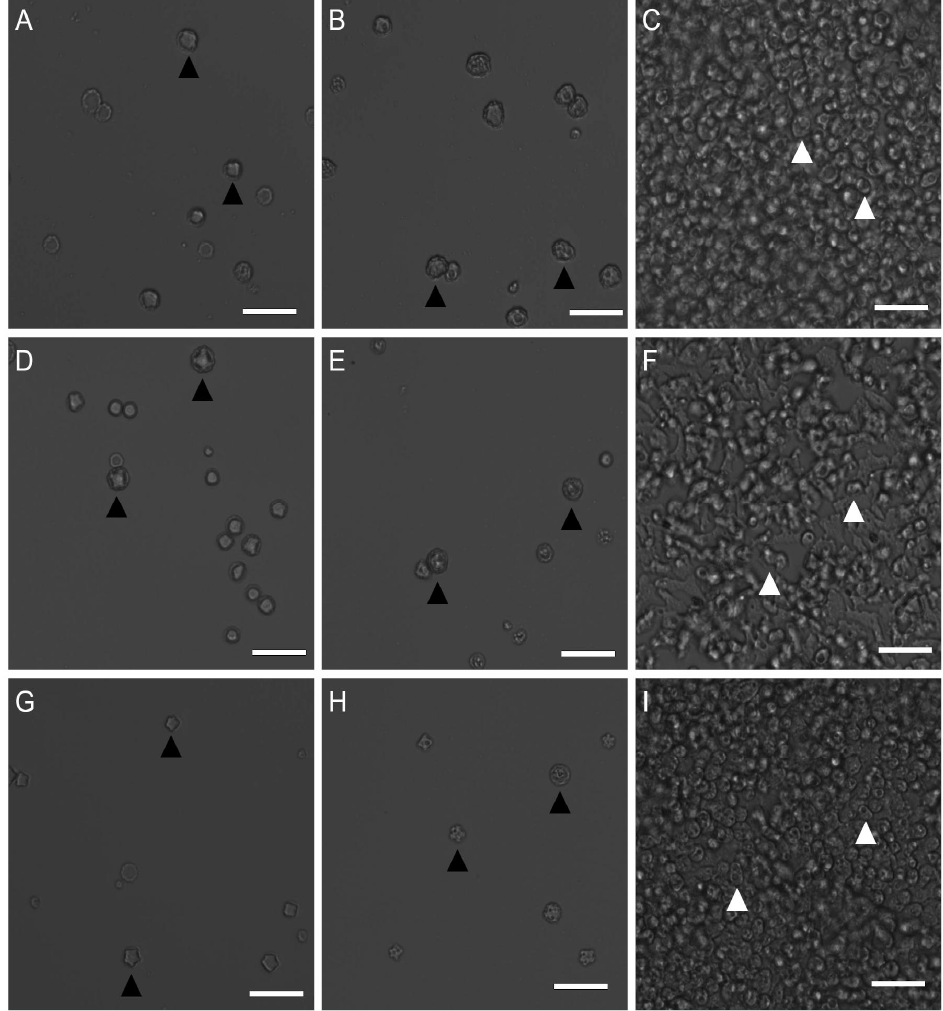
Figure 2. Effect of isavuconazonium sulfate on the morphology of Acanthamoeba Ma, CDC:V240 and MEEI 0184 cysts. Ma cysts were treated with ( A ) 170 μ M isavuconazonium, ( B ) 461.85 μ M PHMB, ( C ) 0.5% ( v / v ) DMSO. CDC:V240 strain cysts were treated with ( D ) 140 μ M isavuconazonium, ( E ) 461.85 μ M PHMB, ( F ) 0.5% ( v / v ) DMSO. MEEI 0184 strain cysts were treated with ( G ) 190 μ M isavuconazonium, ( H ) 461.85 μ M PHMB, ( I ) 0.5% ( v / v ) DMSO. Morphology and excystation of Acanthamoeba T4 cysts after 7 days of incubation in PYG growth media are displayed. Black arrowheads: cysts. White arrowheads: trophozoites. Magnification: 200×. Scale bar: 50 μ m.